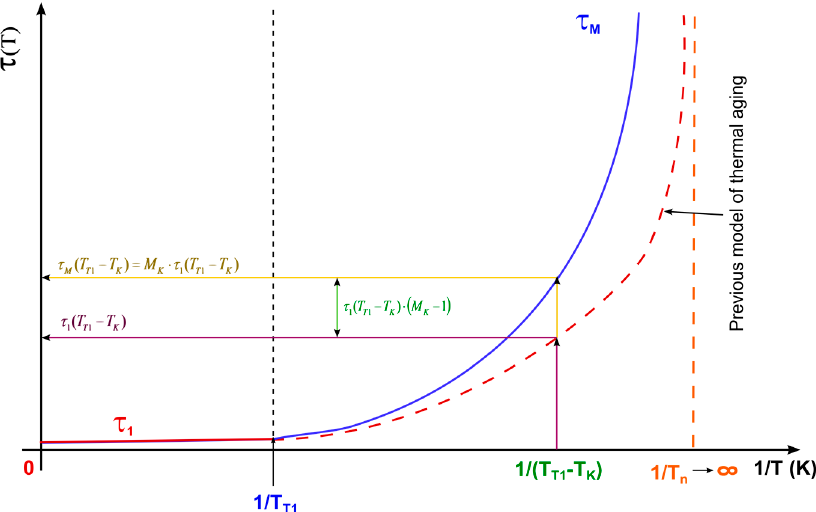
Figure A3. A graphical representation of the constant D , estimating the synergistic effect of the partial degradation mechanisms.